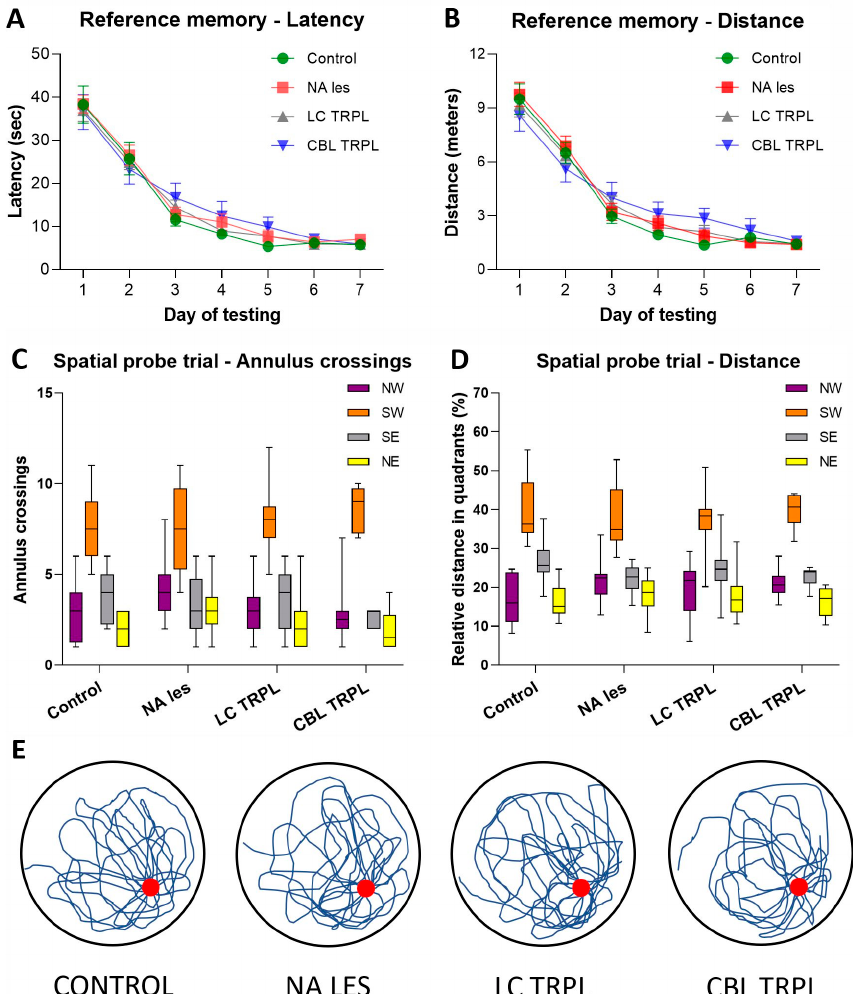
Figure 2. Morris Water Maze reference memory test performed about 32 weeks post-lesioning and grafting. All animals showed equally efficient abilities both in latency ( A ) and distance ( B ). Each sample point represents the mean value for the block of four trials on each of seven consecutive days of testing ± SEM. In the lower diagrams, the average number of annulus crossings ( C ), the mean relative distance ( D ) swam in each quadrant during the spatial probe trial and the actual swim paths taken by representative rats from the various groups ( E ) are illustrated. All animals mainly swam in the training (SW) quadrant, indicating that the selective noradrenergic lesion or the grafting procedures have no e ff ects on reference memory performance.